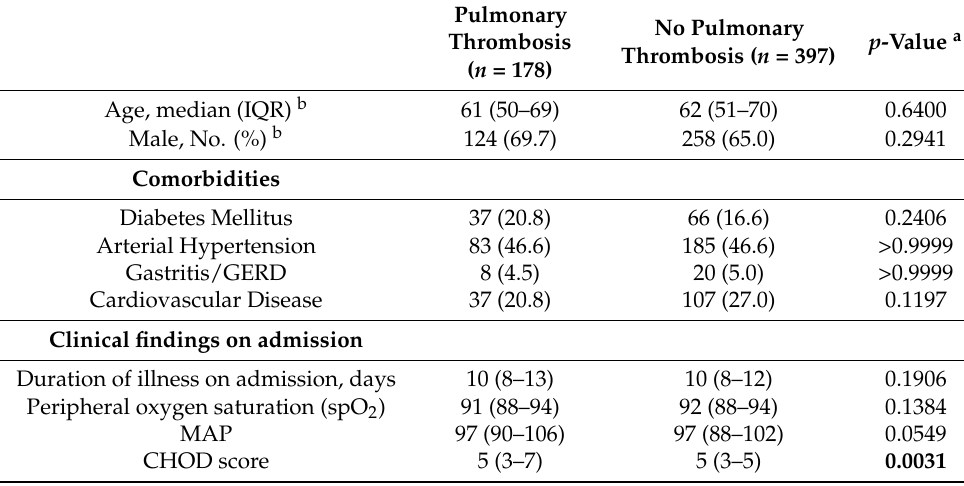
Table 1. Baseline patients’